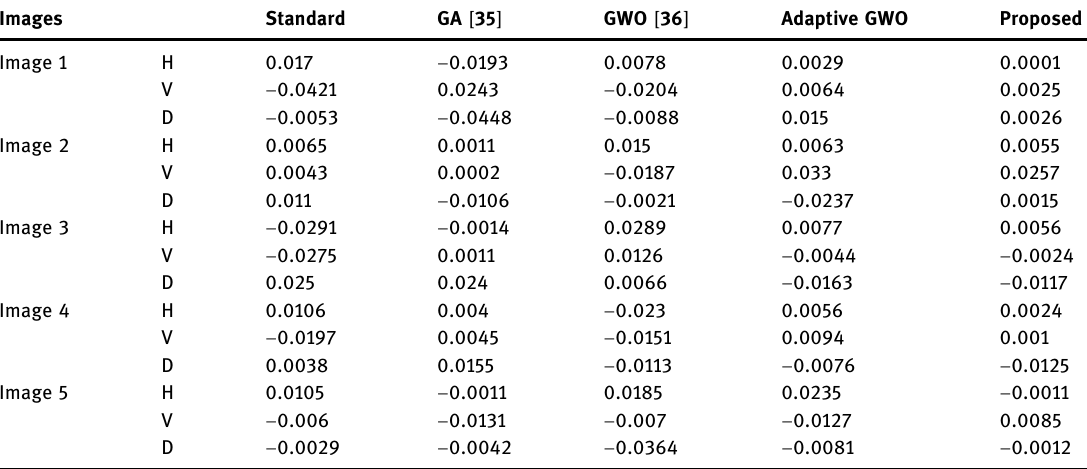
Table 3: Autocorrelation analysis of adjacent pixels by using CT images Images